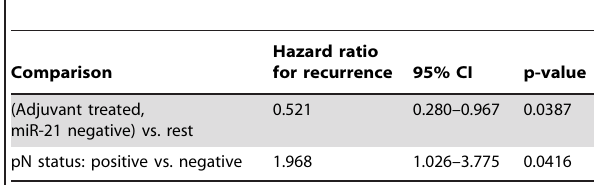
Table 6. Multivariate analysis of adjuvant treated patients: